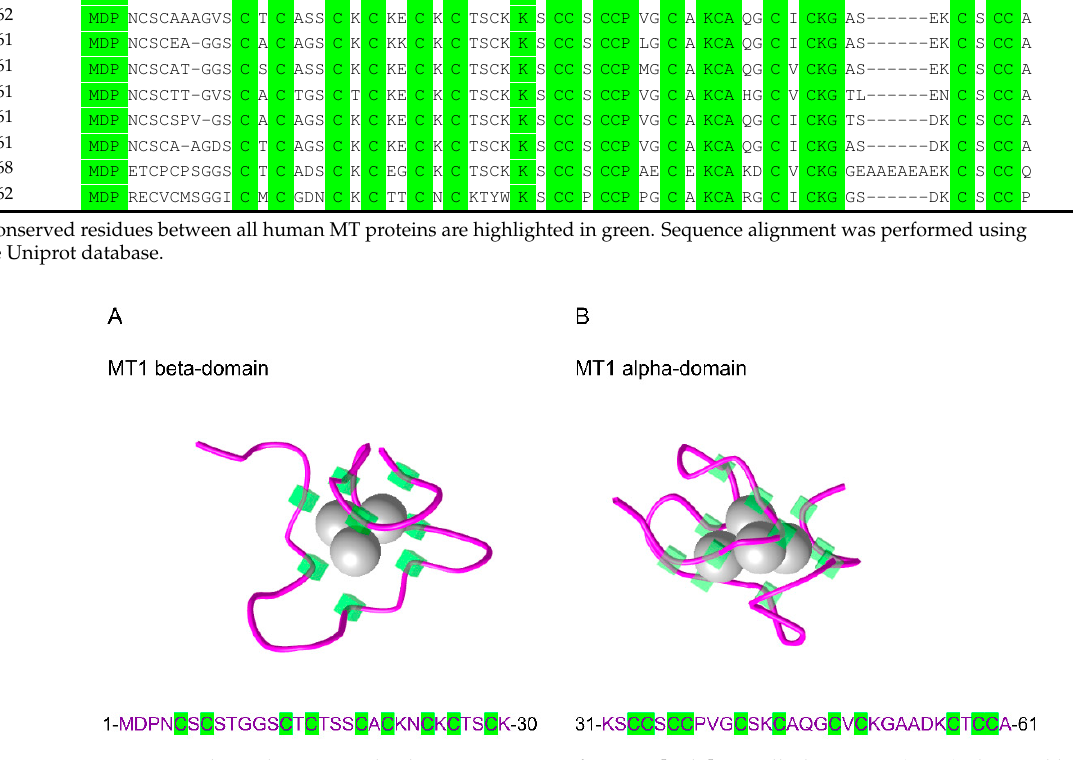
Figure 1. Three-dimensional solution structure of mouse [Cd7]-metallothionein 1 (MT1) obtained by NMR spectroscopy. ( A ) Mouse MT1 beta-domain with 3 Cd atoms and ( B ) mouse MT1 alpha-domain Figure 1. Three ‐ dimensional solution structure of mouse [Cd7] ‐ metallothionein 1 (MT1) obtained by NMR spectroscopy. with 4 Cd atoms. The amino acid sequence is indicated below each domain structure. The protein ( A ) Mouse MT1 beta ‐ domain with 3 Cd atoms and ( B ) mouse MT1 alpha ‐ domain with 4 Cd atoms. The amino acid se ‐ sequence is represented in purple, and the cysteine residues are highlighted in green. Data were quence is indicated below each domain structure. The protein sequence is represented in purple, and the cysteine residues obtained from the NCBI’s Molecular Modeling Database (MMDB ID 12319 and are highlighted in green. Data were obtained from the NCBI’s Molecular Modeling Database (MMDB ID 12319 and 12320).